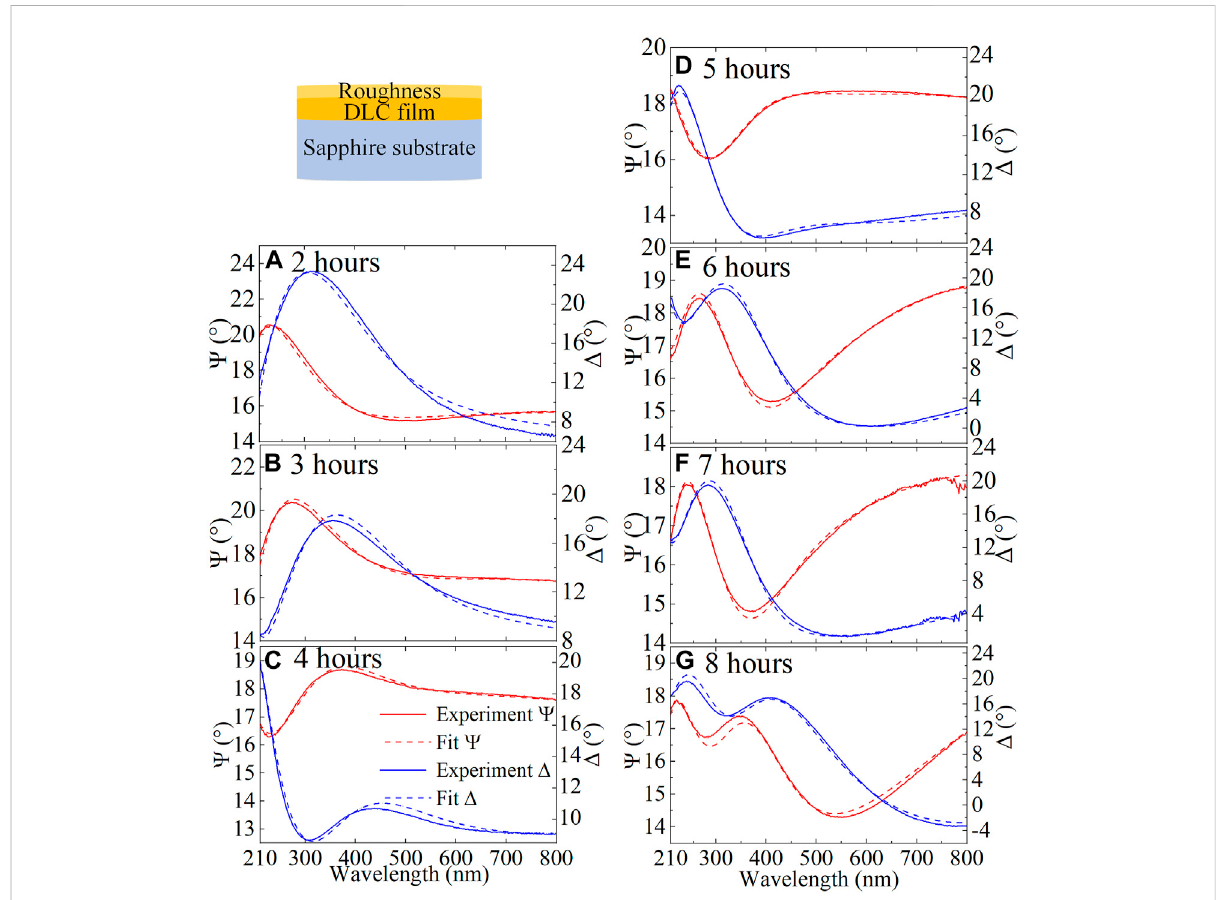
FIGURE 5 Ψ and Δ spectra measured at 70 ° (A) the 2 h sample, (B) the 3 h sample, (C) the 4 h sample, (D) the 5 h sample, (E) the 6 h sample, (F) the 7 h sample and (G) the 8 h sample. The fi t is also included.